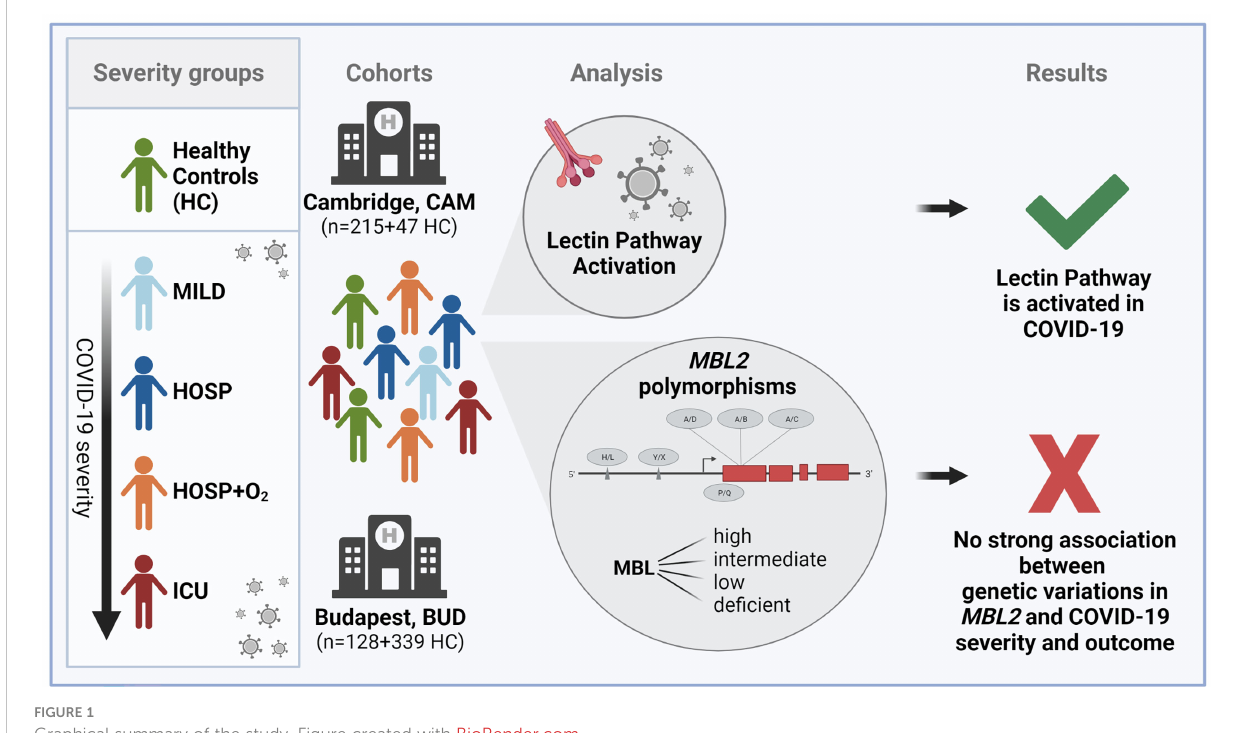
FIGURE 1 Graphical summary of the study. Figure created with